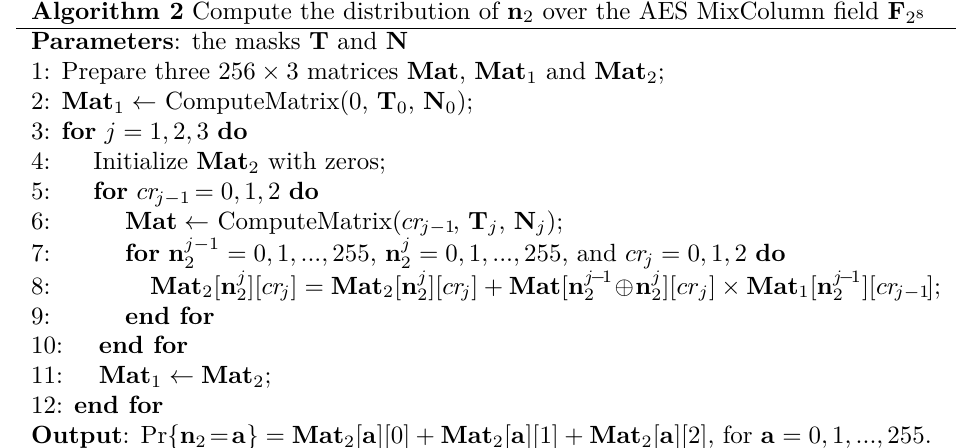
Algorithm 2 Compute the distribution of n 2 over the AES MixColumn field F